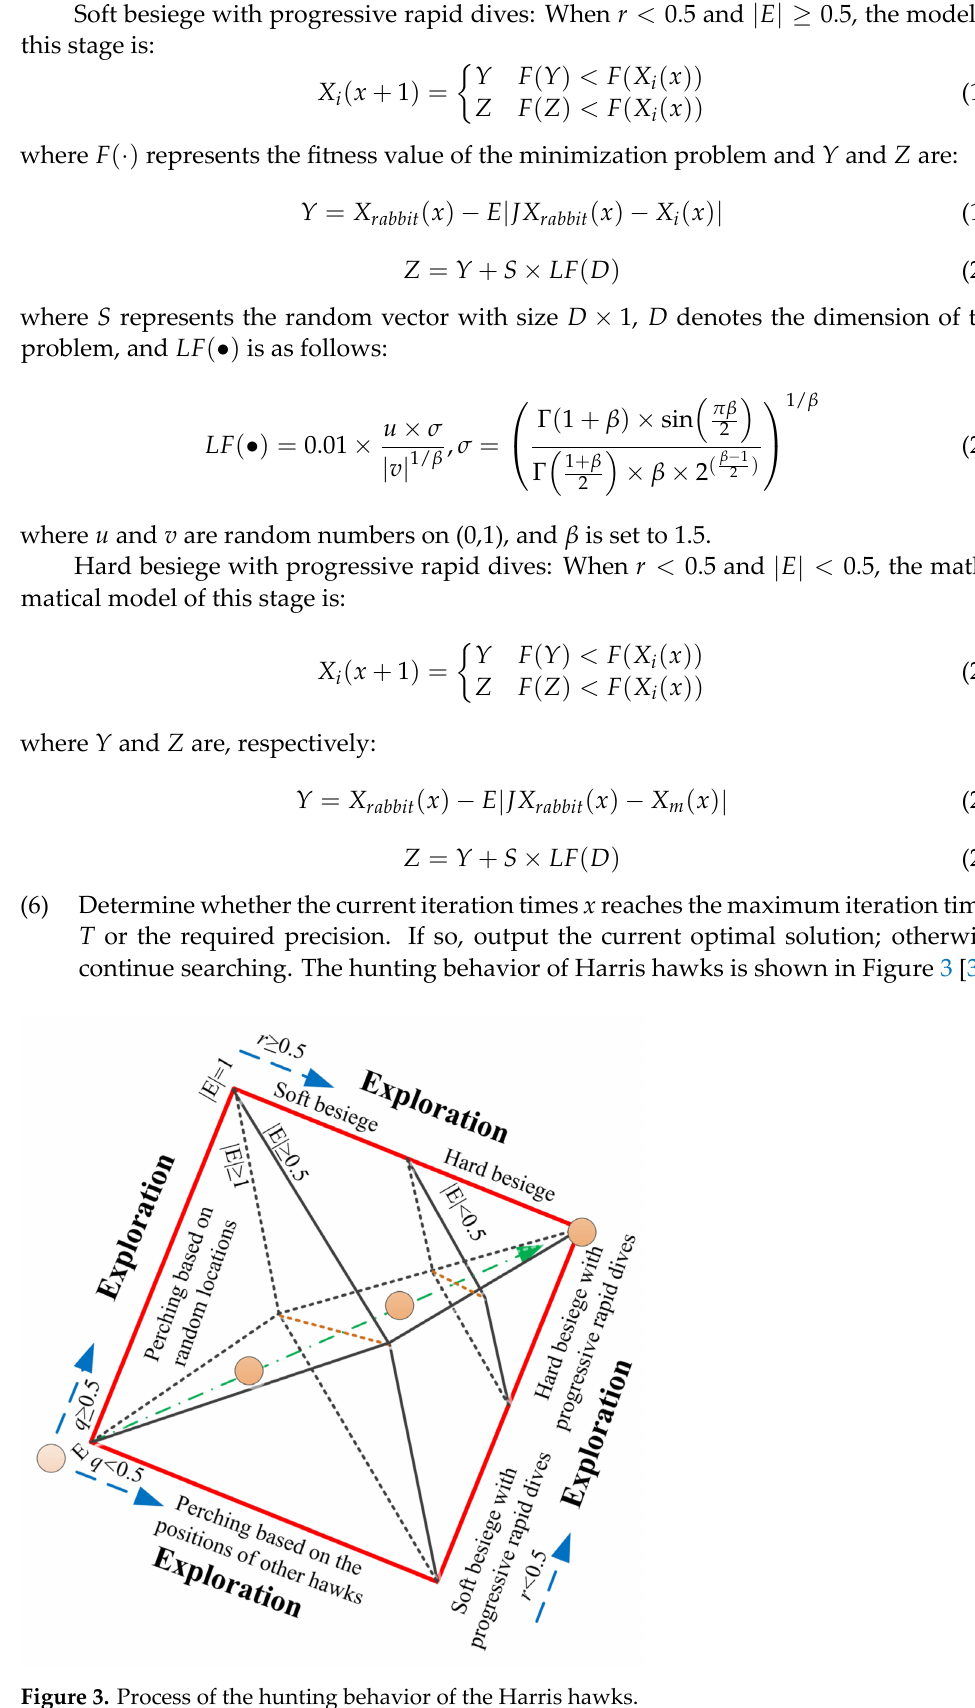
Figure 3. Process of the hunting behavior of the Harris